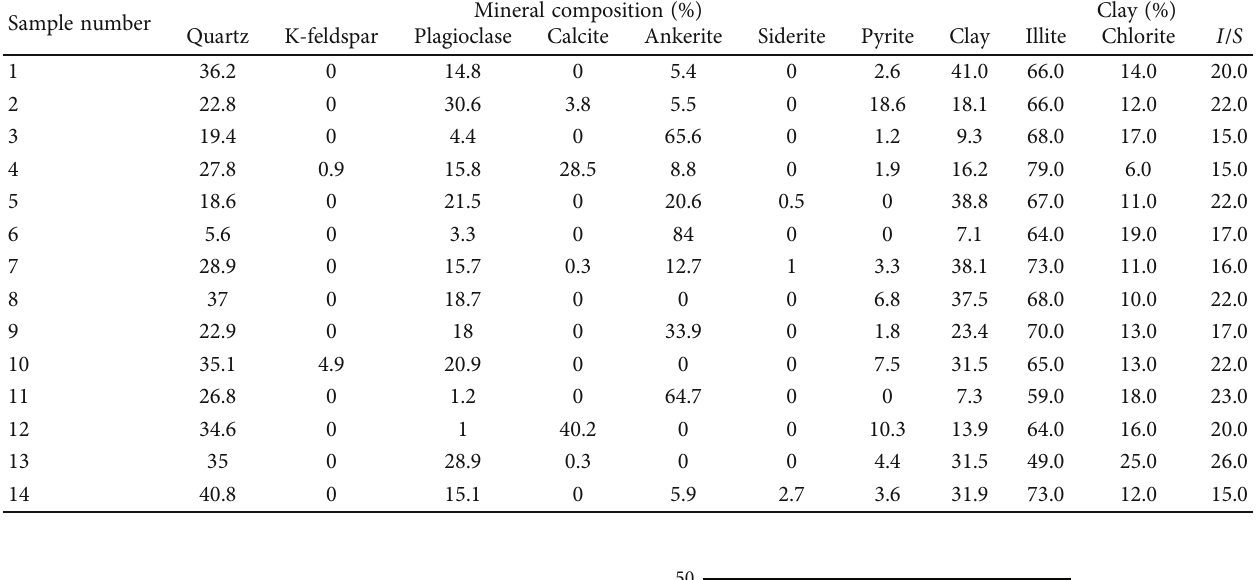
Table 2: XRD results of the shale samples from the K